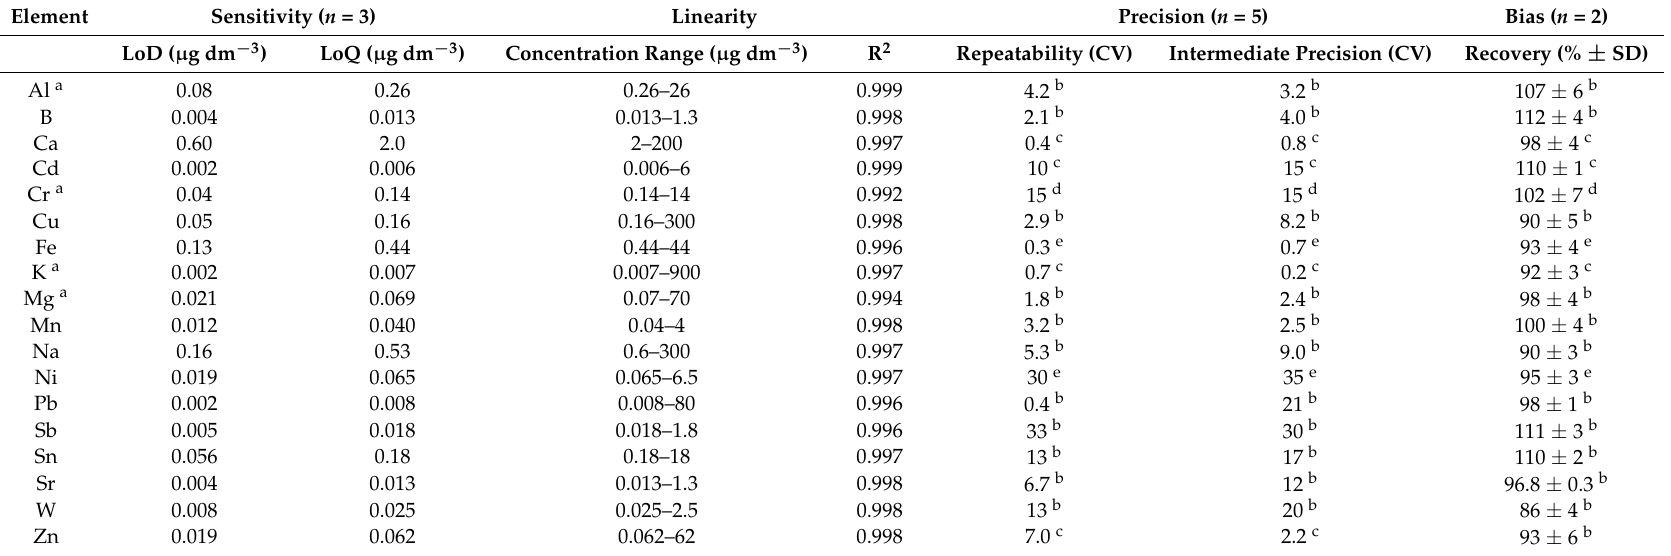
Table 3. Validation data for the ICP-MS determination of elements in Filuferru